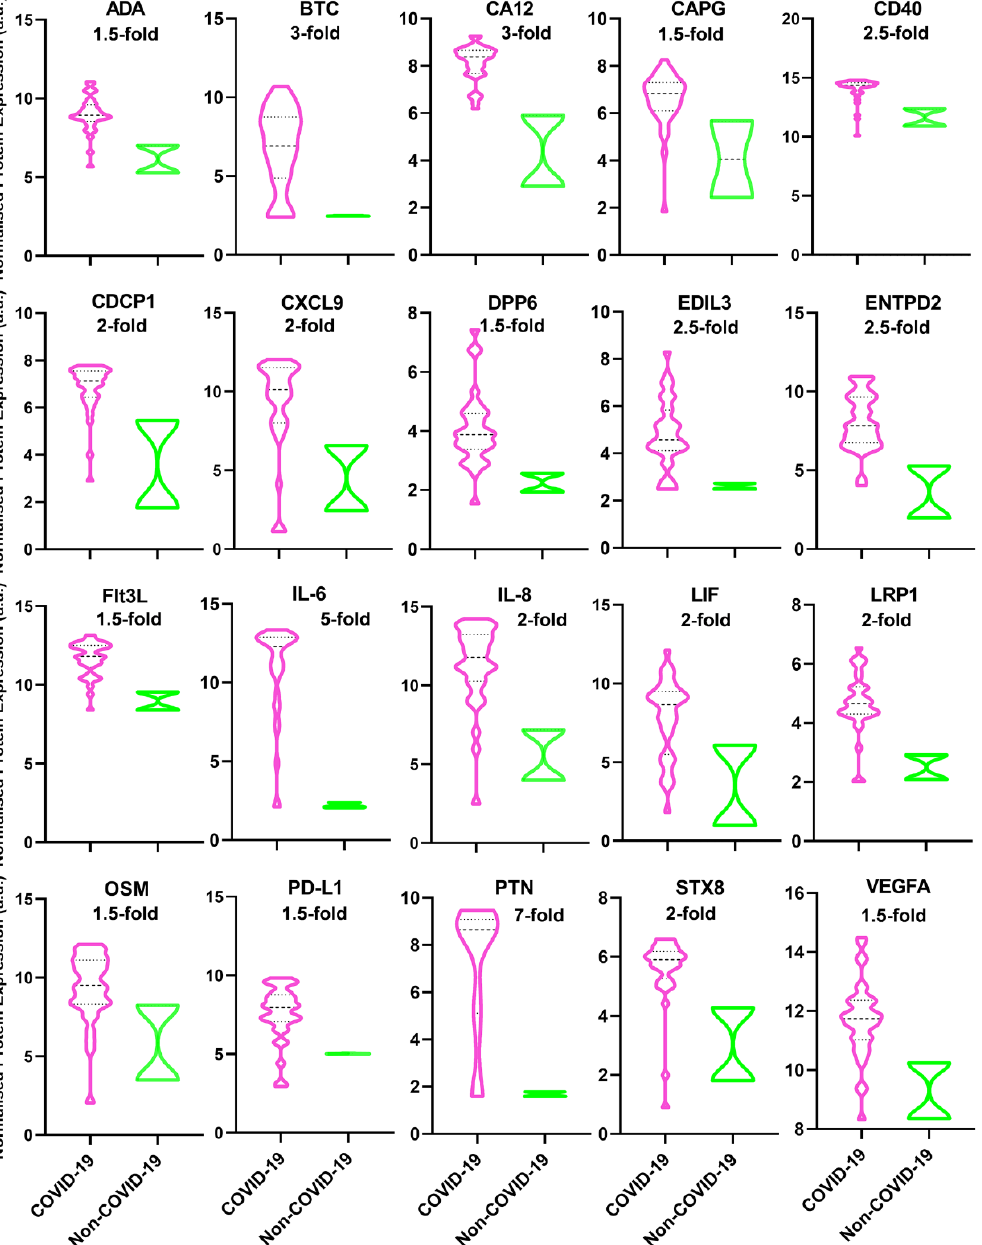
Figure 2. Levels of 20 inflammatory and organ-damage markers were upregulated in deceased COVID-19 patients. All the data presented are statistically significant ( p < 0.05) compared to the control (non-COVID-19 patients) (COVID-19 cohort = 29, non-COVID-19 cohort = 2, n = 2). For the populations that were following normal distribution, a student unpaired t-test was used including BTC, DPP6, EDIL3, ENTPD2, FIt3L, IL-6, OSM, PD-L1, PTN, and VEGFA. For populations that